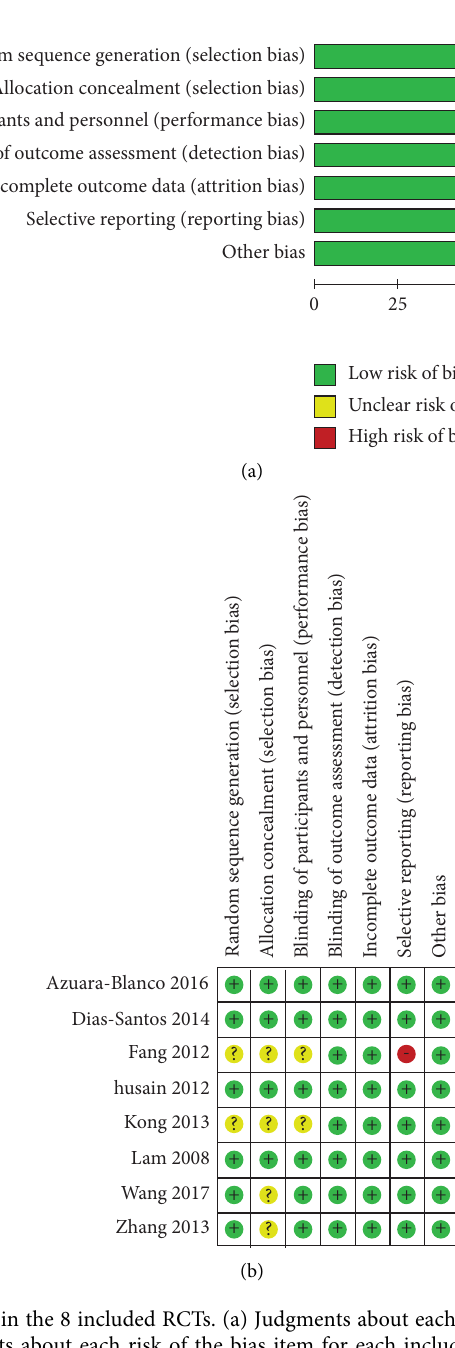
Figure 2: Assessment of the risk of bias in the 8 included RCTs. (a) Judgments about each risk of the bias item presented as percentages across all included studies. (b) Judgments about each risk of the bias item for each included